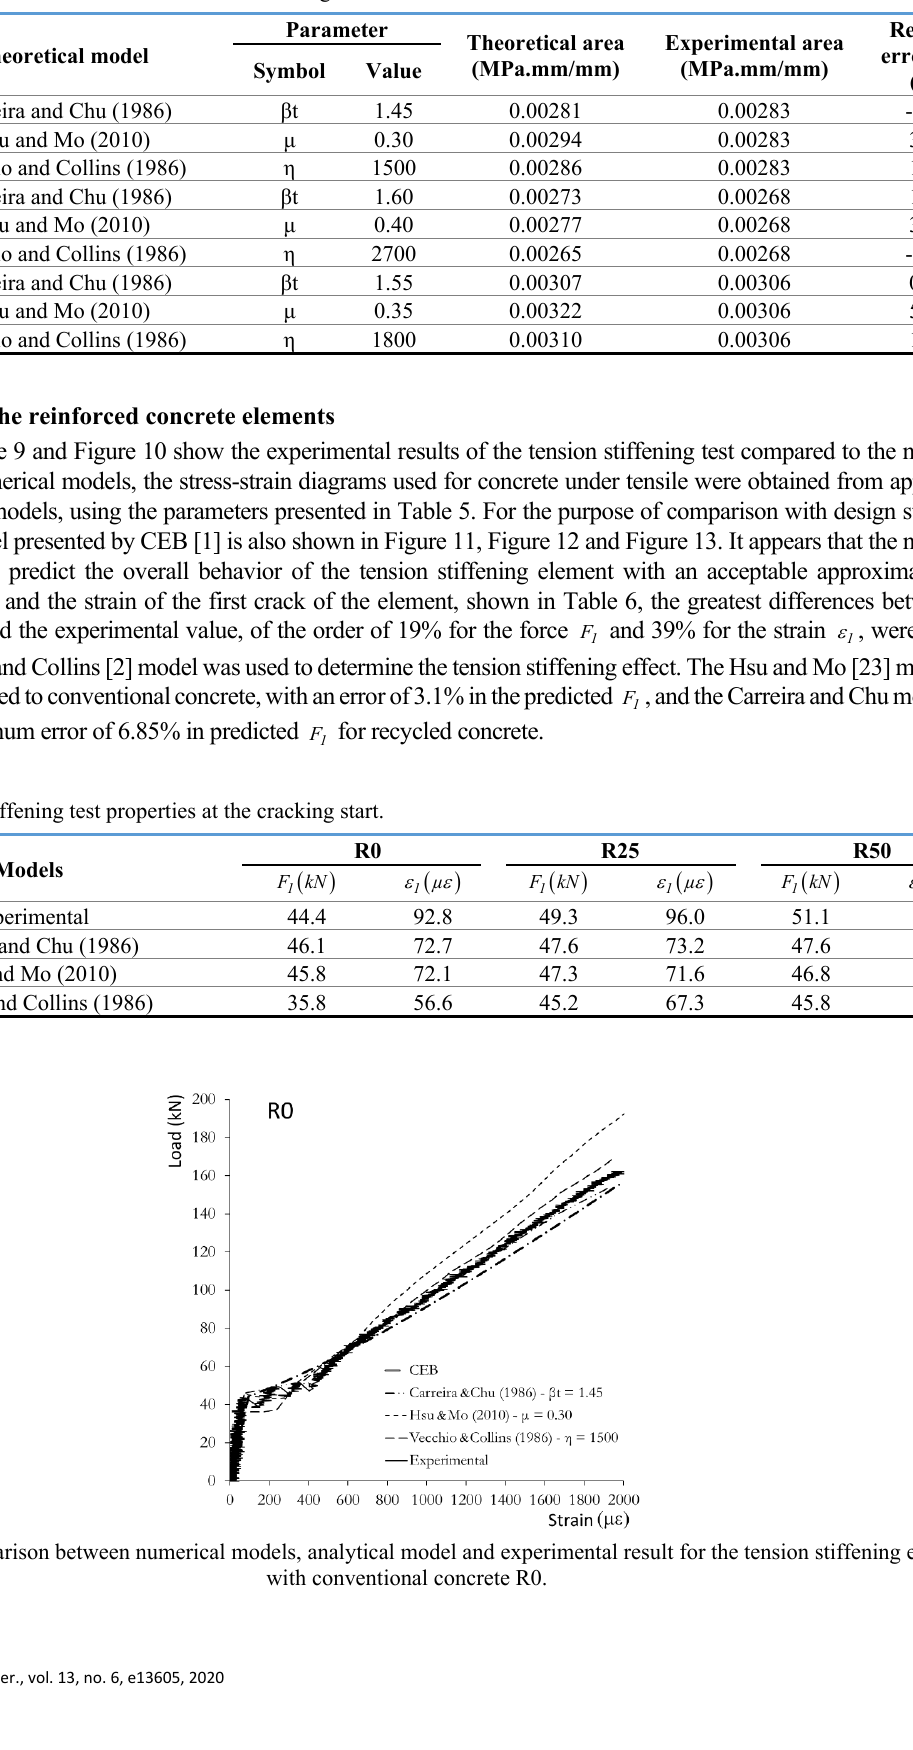
Table 5. Parameter values obtained for tension stiffening models.